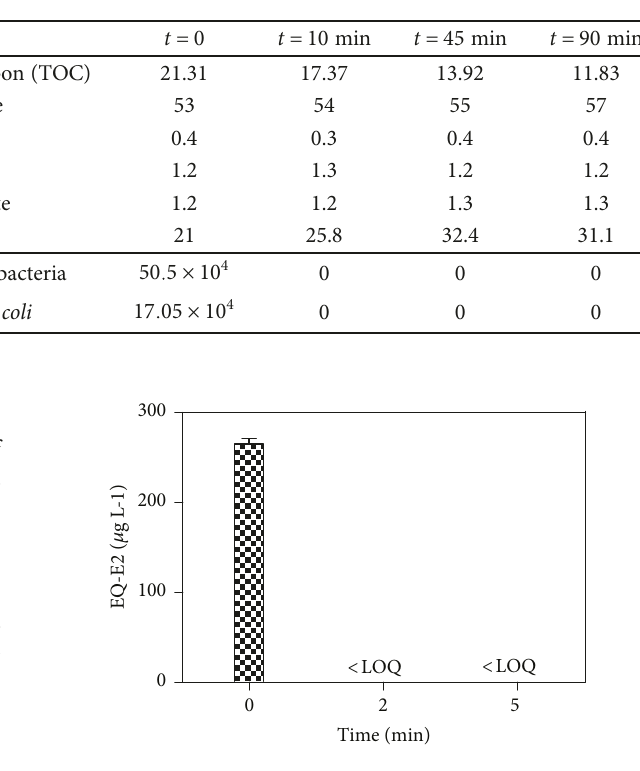
Figure 4: Estrogenic activity reduction using a combined Cl/UVC treatment containing BPA, E2, and EE2 in solution. Initial EDC concentrations: 100 μ g · L -1 , initial chlorine concentration=2mg · L -1 , UVC irradiance=14.79mW cm -2 , reaction time=5min. < LOQ = below the limit of quanti fi cation.